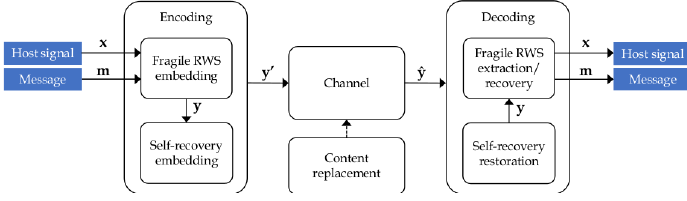
Figure 1. Framework for robust RWS with signal restoration.